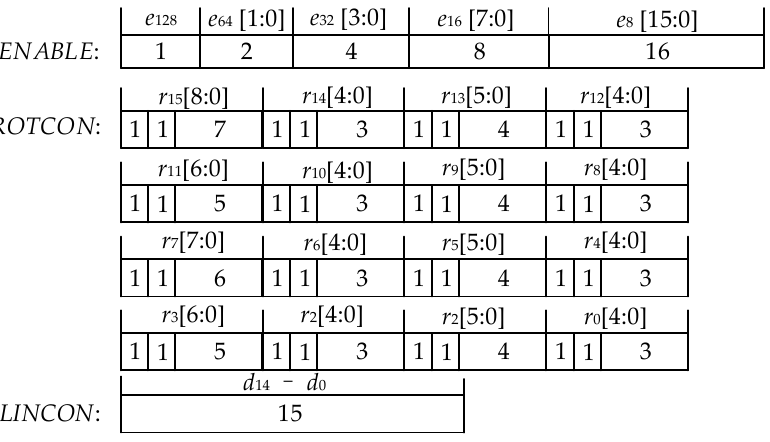
Figure 5. The format of RSTU configuration word.